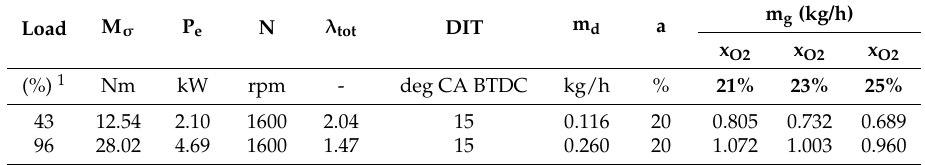
Table 3. Experimental data for NG/DDF engine operating mode with “normal pilot fuel” quantity,